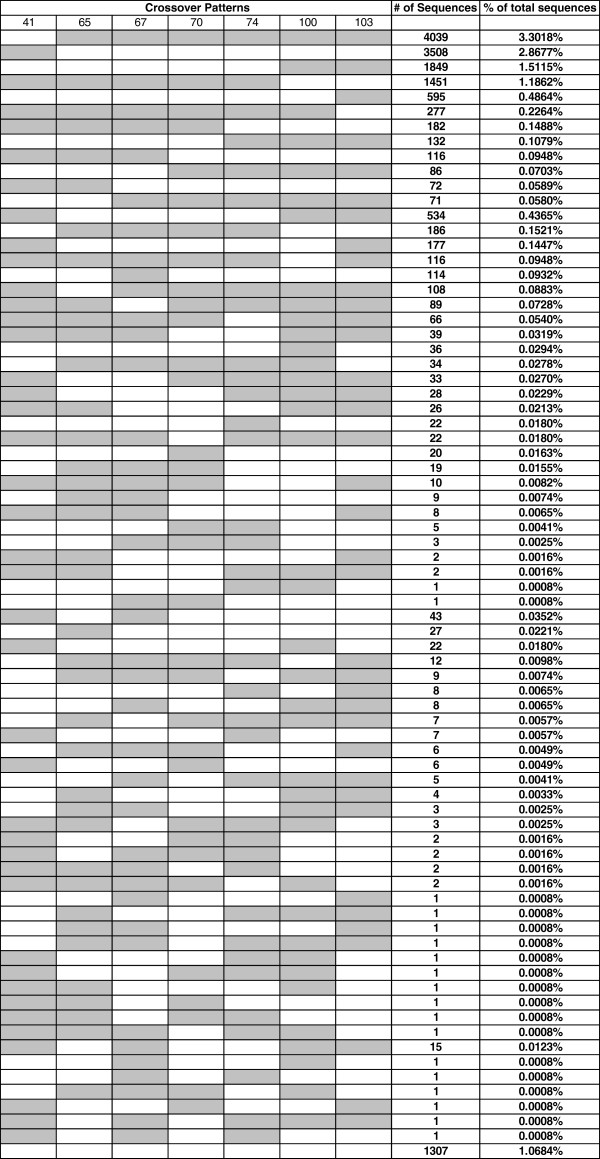
Crossover patterns of recombinant sequences from Run3 MID12 analyzed using standard PCR conditions. The second row shows the drug resistance codon positions. The 1st to the 7th columns show the nucleotides at each of the 7 sites with WT marked in white and mutant marked in gray. Detectable crossover events are shown as color changes (from white to gray or from gray to white). The last row represents recombinants that have one or more nucleotides in the drug resistance codons missing from sequencing.